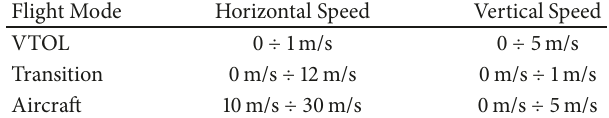
Table 2: VTOL flight